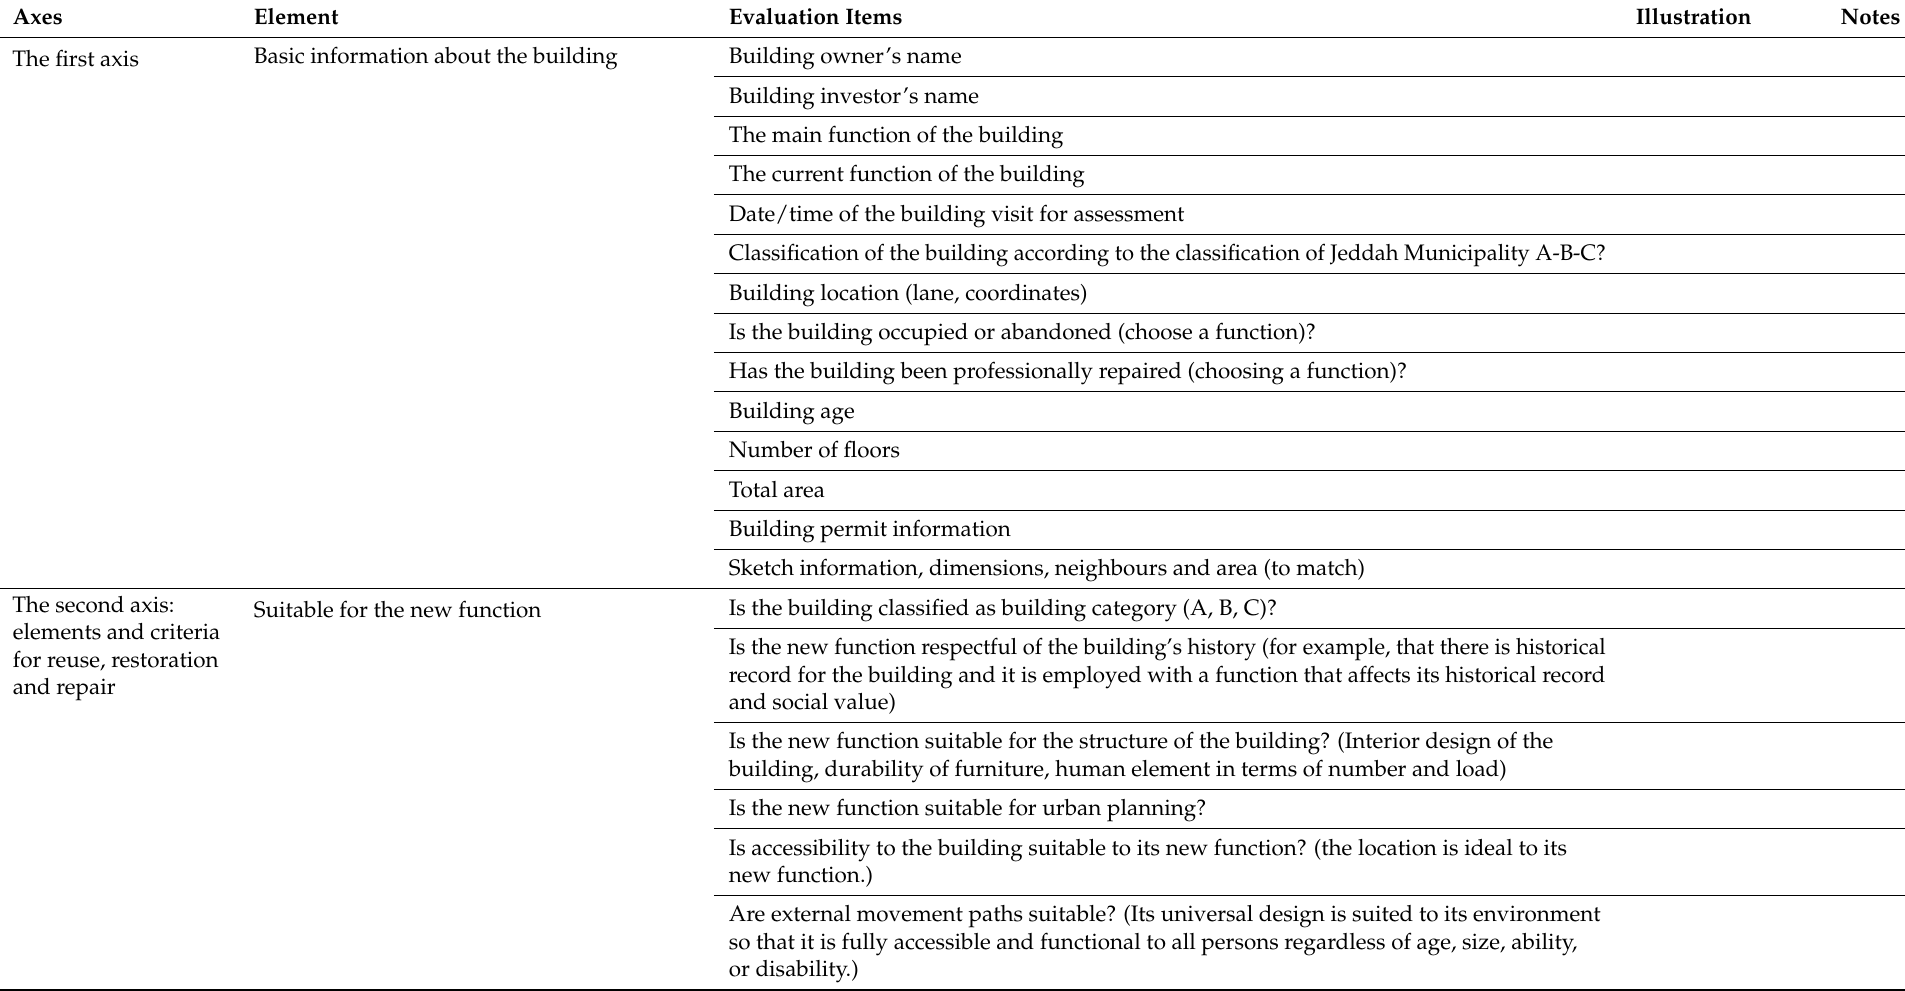
Table 16. Final model for evaluation of the adaptive reuse of historical